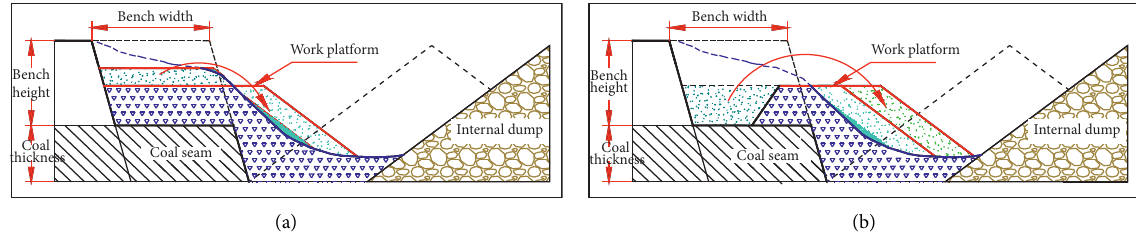
Figure 2: Section view of muck pile with dragline operation in extended platform. (a) Muck pile is leveled to establish an extended platform. (b) Dragline standing on the extended platform makes dumping